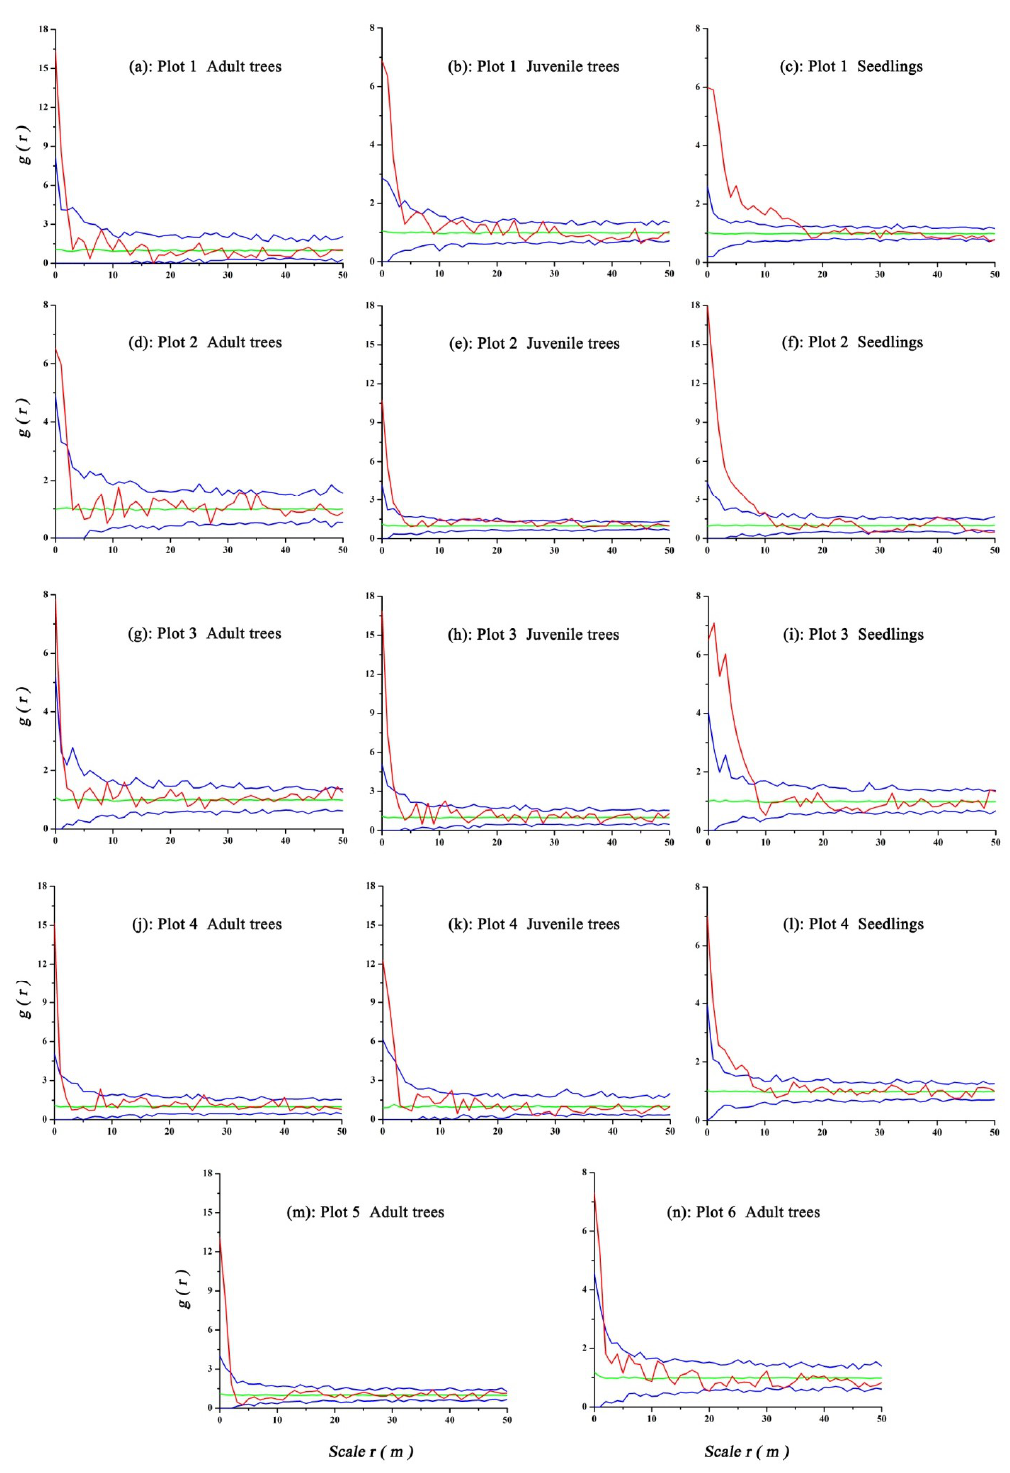
Figure 4. Spatial pattern of the different categories of U. pumila using the complete spatial randomness (CSR) null model. The red line indicates the value of the summary function for the data point pattern, the blue line indicates the confidence interval using the Monte Carlo test, and the green line indicates the reference line. The number of simulated point pattern was 99%.